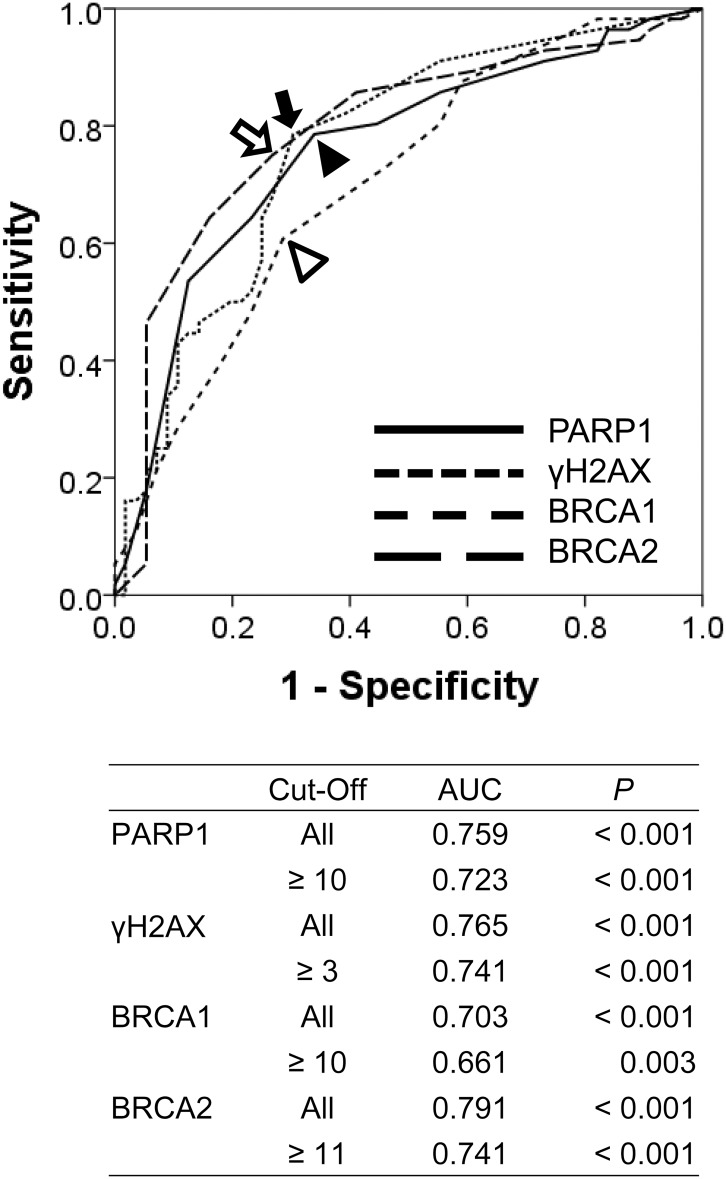
Statistical analysis to determine the cut-off points for the immunohistochemical staining scores of PARP1, γH2AX, BRCA1, and BRCA2.The cut-off points for the immunohistochemical staining of PARP1 (black arrow head), γH2AX (black arrow), BRCA1 (empty arrow head), and BRCA2 (empty arrow) were determined by the receiver operating characteristic curve analysis at the highest AUC (area under the curve) value for the estimation of the event of disease-specific survival of patients. Cases with scores equal to or greater than 10 for PARP1 and BRCA1 expression were considered positive. The expression of γH2AX was considered positive when the number of γH2AX-positive cells was equal to or greater than three. The expression of BRCA2 was considered positive when the scores were equal to or greater than 11.